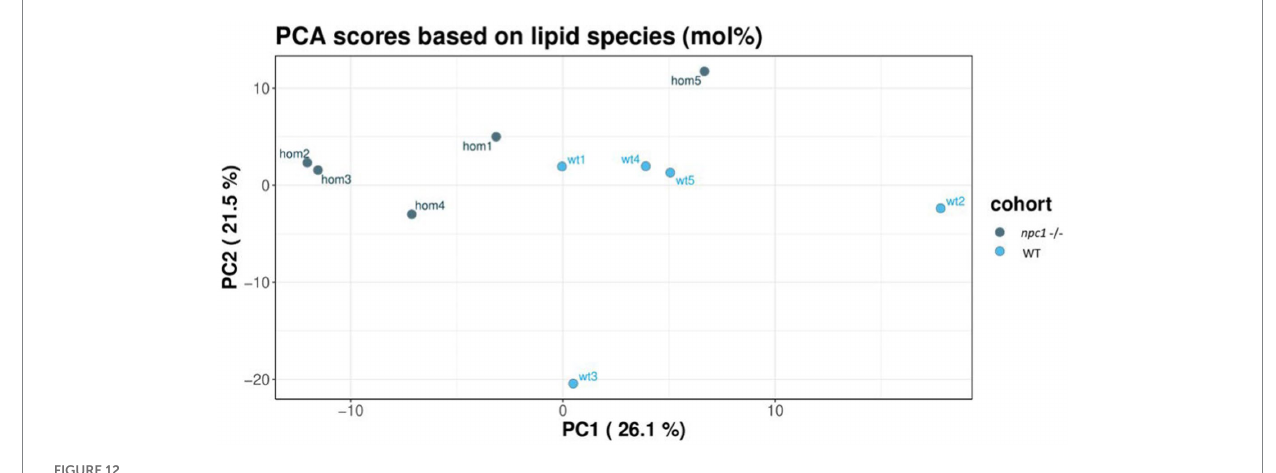
FIGURE 12 Principal component analysis of the lipidomic